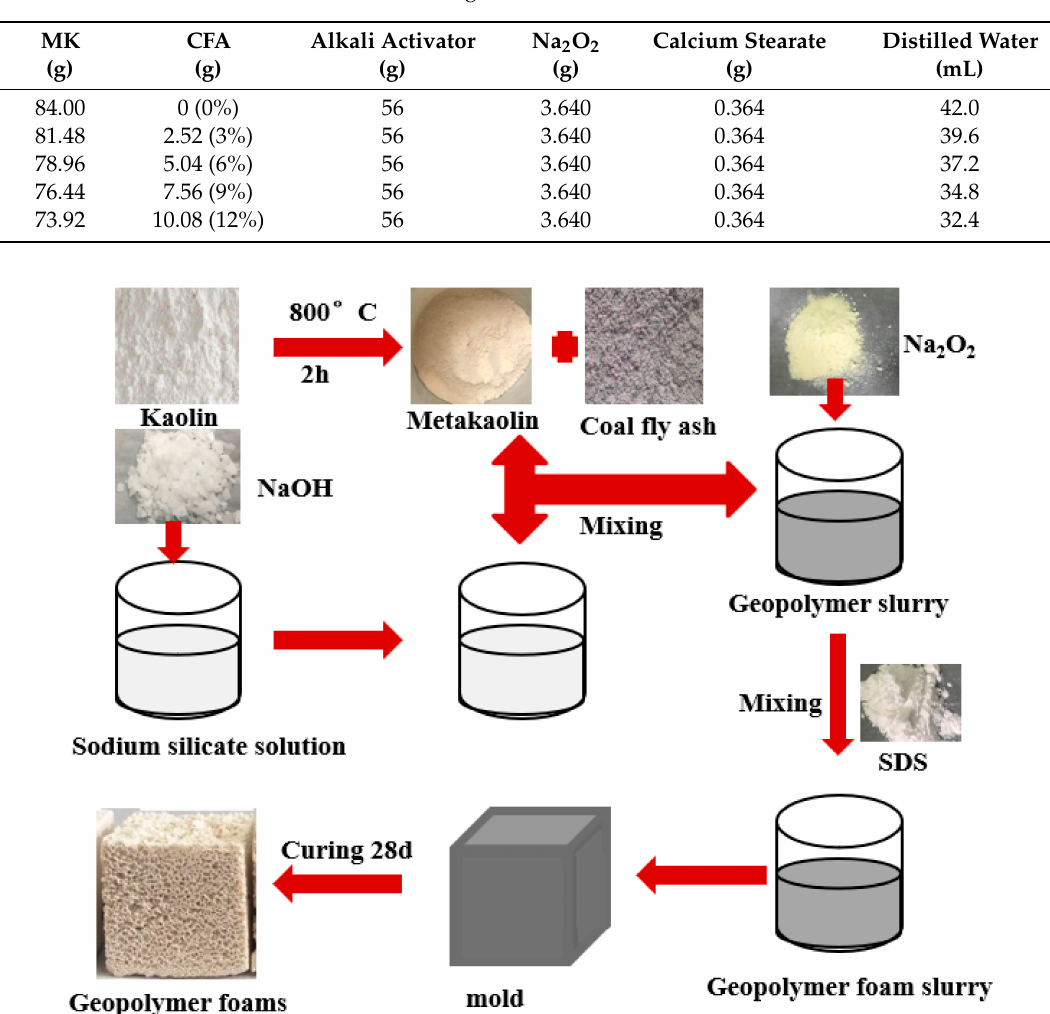
Figure 1. Preparation process of the CFA-MK-based